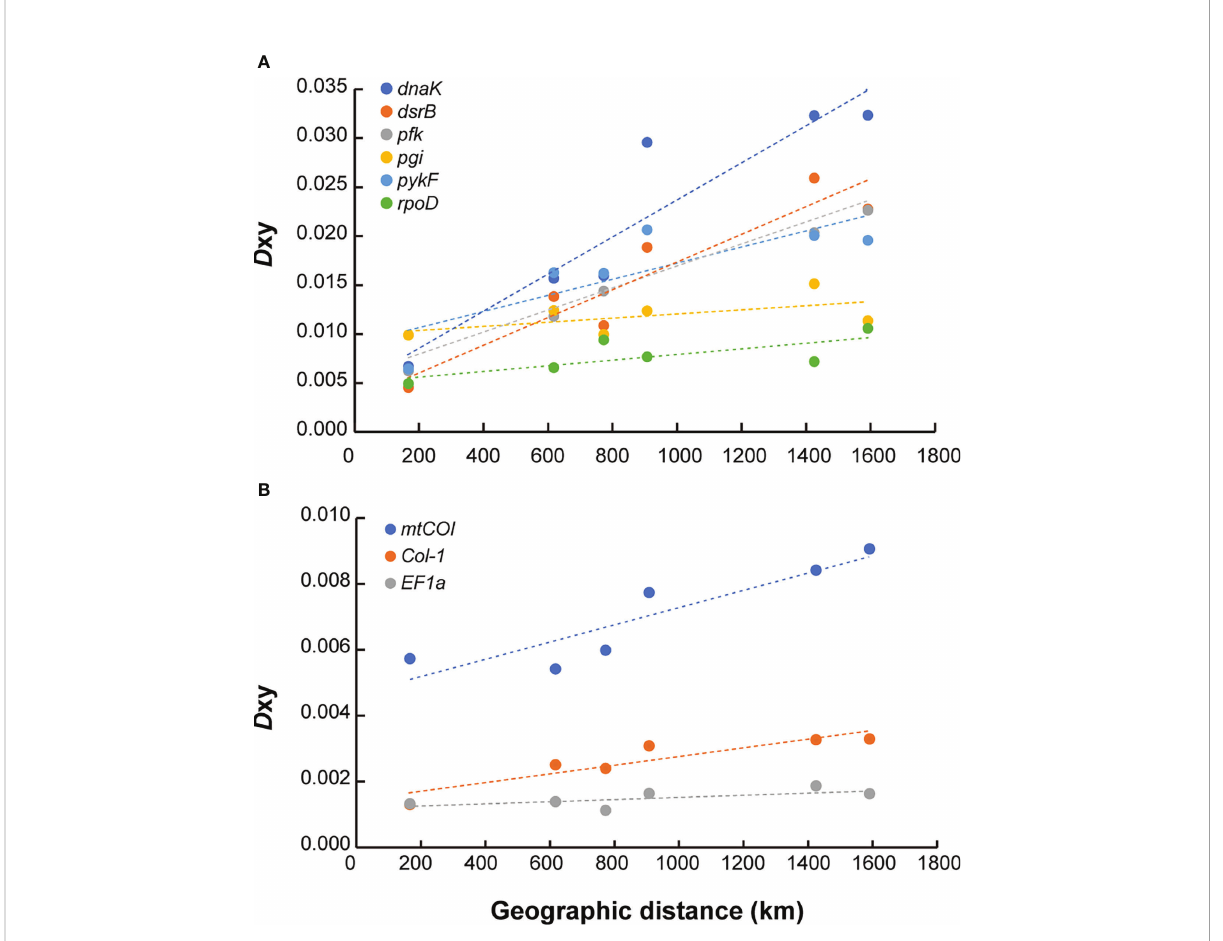
FIGURE 6 Correlation of population divergence ( D xy ) with geographic distance for functional genes in the CIR. (A) Symbiotic bacteria. (B) Host mussels. The dashed lines represent the linear regression lines of each